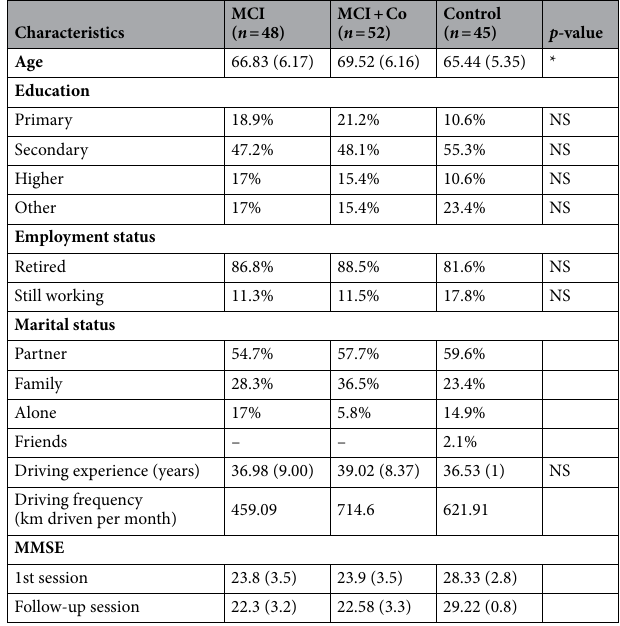
Table 3. Characteristics of the participants . MMSE, Mini-mental state examination; MCI, mild cognitive impairment; NS, Non-Statistically significant.